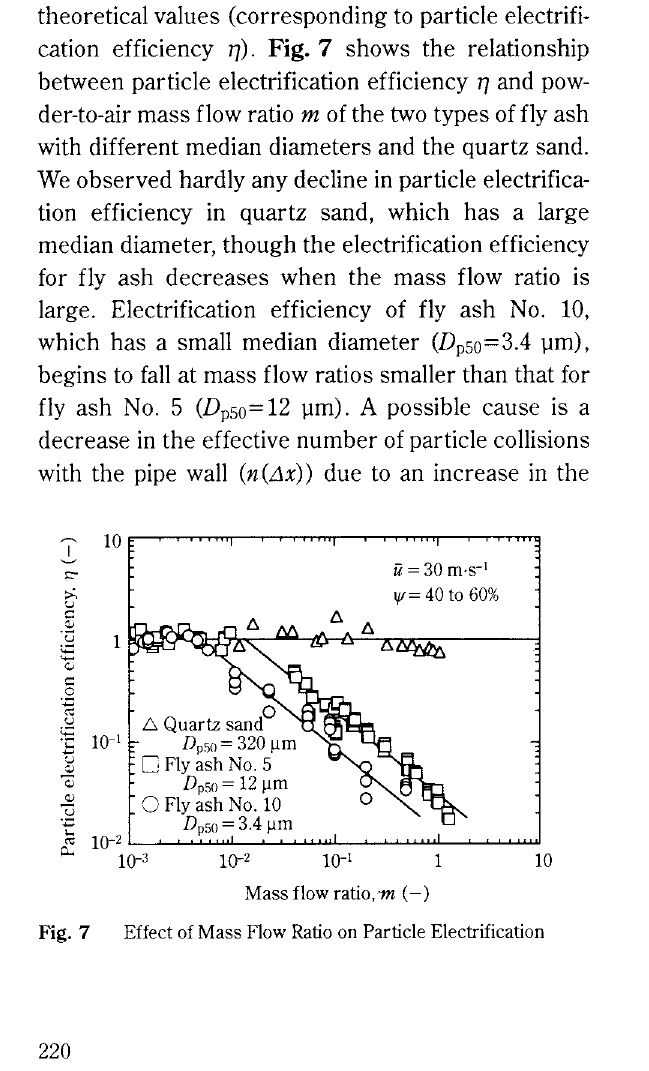
Effect of Mass Flow Ratio on Particle